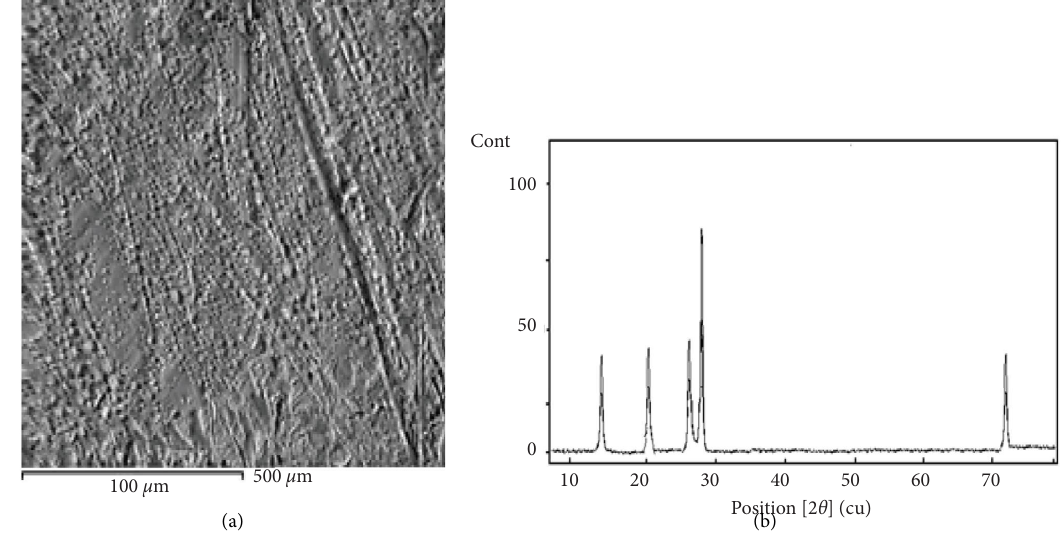
Figure 11: (a) Scanning electron microscope (SEM) and (b) X-ray difraction (XRD) of PSA.